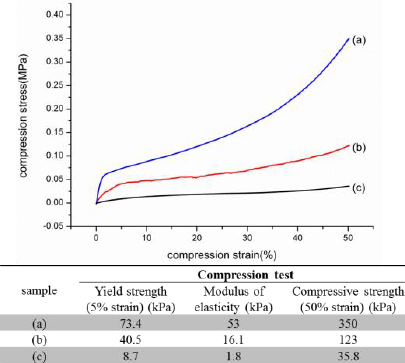
Figure 6. Stress-strain curves of nHap/Col composite scaffolds with different preparation process by compression test: ( a ) self-assembled mineralization method for 24 h reaction; ( b ) self-assembled mineralization method for 3 h reaction; ( c ) hydroxyapatite powder directly added into collagen slurry as simple mixture method. The mechanical properties of nHap/Col composite scaffold were summarized in the table.